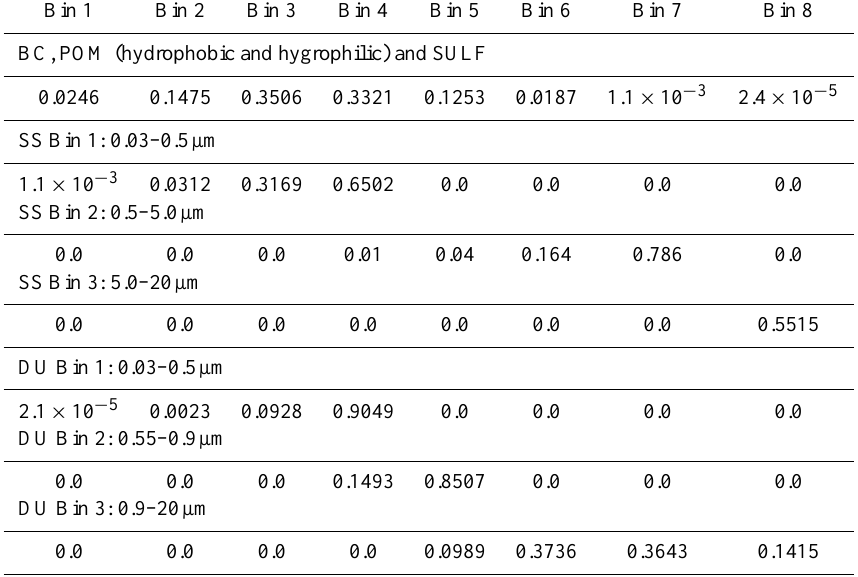
Table 3. Fractional apportionment of aerosol loadings from MACC-II model to eight MOSAIC size bins for initial and boundary conditions (Morcrette et al., 2009). Apportioning for MACC-II aerosol species are: black carbon (BC); organic aerosol (OA); sulfate aerosol (SULF); dust (DU); and sea salt (SS). This table uses the same MOSAIC dry particle diameters as Table 1. Bin 1 Bin 2 Bin 3 Bin 4 Bin 5 Bin 6 Bin 7 Bin 8 BC, POM (hydrophobic and hygrophilic) and SULF 0.0246 0.1475 0.3506 0.3321 0.1253 0.0187 1.1 × 10 − 3 2.4 × 10 −